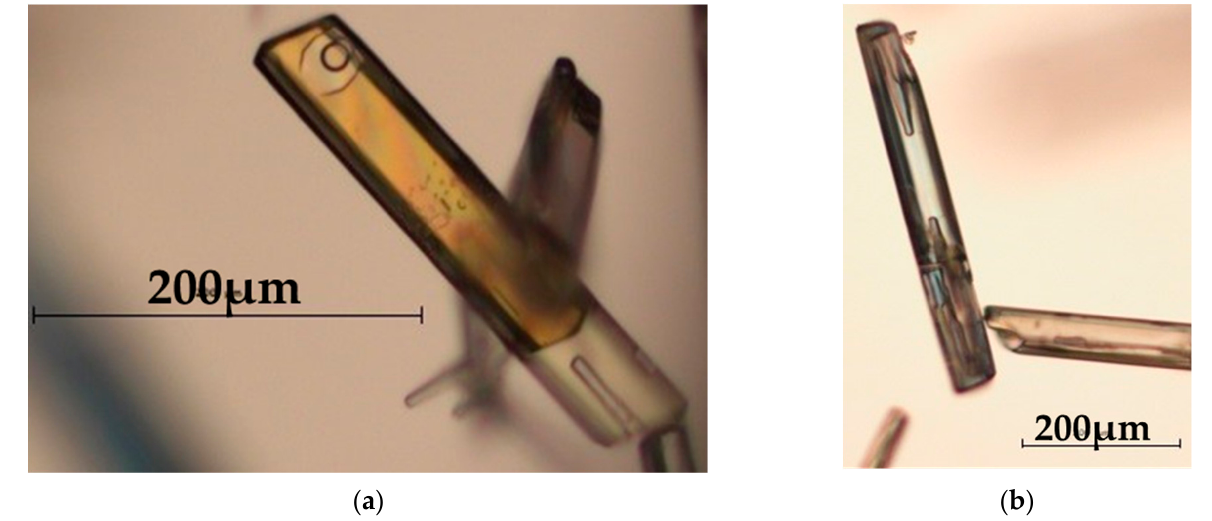
Figure 9. Snapshots obtained by means of polarized light microscopy. ( a ) Particle obtained by cooling from 40 °C to 20 °C of pure S-IBU/S- α MBA in ethanol/water (80/20) mixture; the particle exhibits two colors with a clear dividing line, suggesting that it results in an association of two different crystals. ( b ) Particle obtained by cooling from 40 °C to 20 °C of pure S-IBU/S- α MBA in pure ethanol (99.8%).